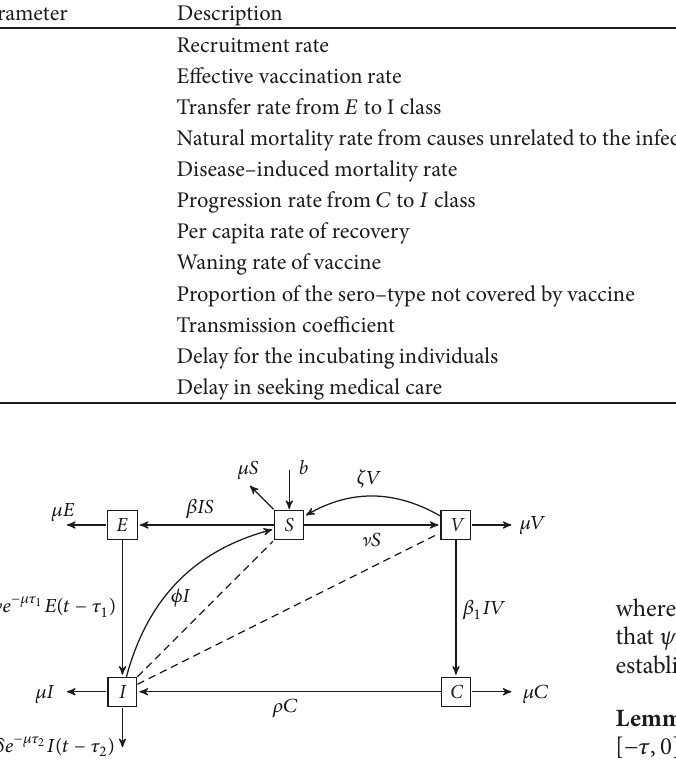
Figure 1: A schematic diagram showing the dynamics of pneu- mococcal pneumonia. The dotted lines represent contacts made by individuals in the respective classes and the solid lines show transfer from one class to